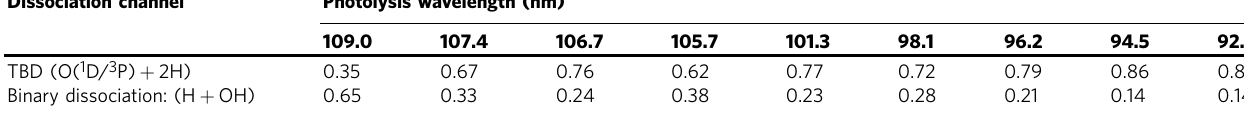
Table 1 The branching ratios for the binary and TBD channels following the H 2 O photodissociation at different VUV wavelengths (nm).